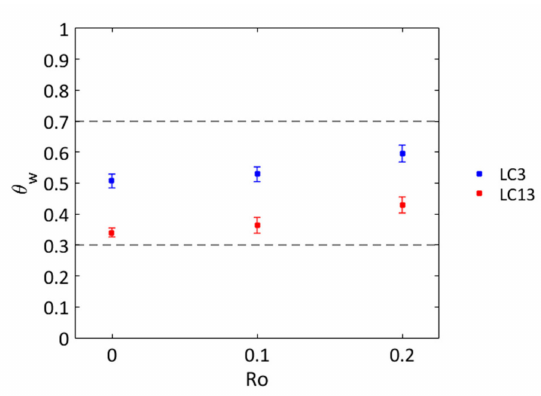
Figure 6. Transient experiment channel model: locations of thermocouples and identification of the regions with the two di ff erent liquid crystals (LC).